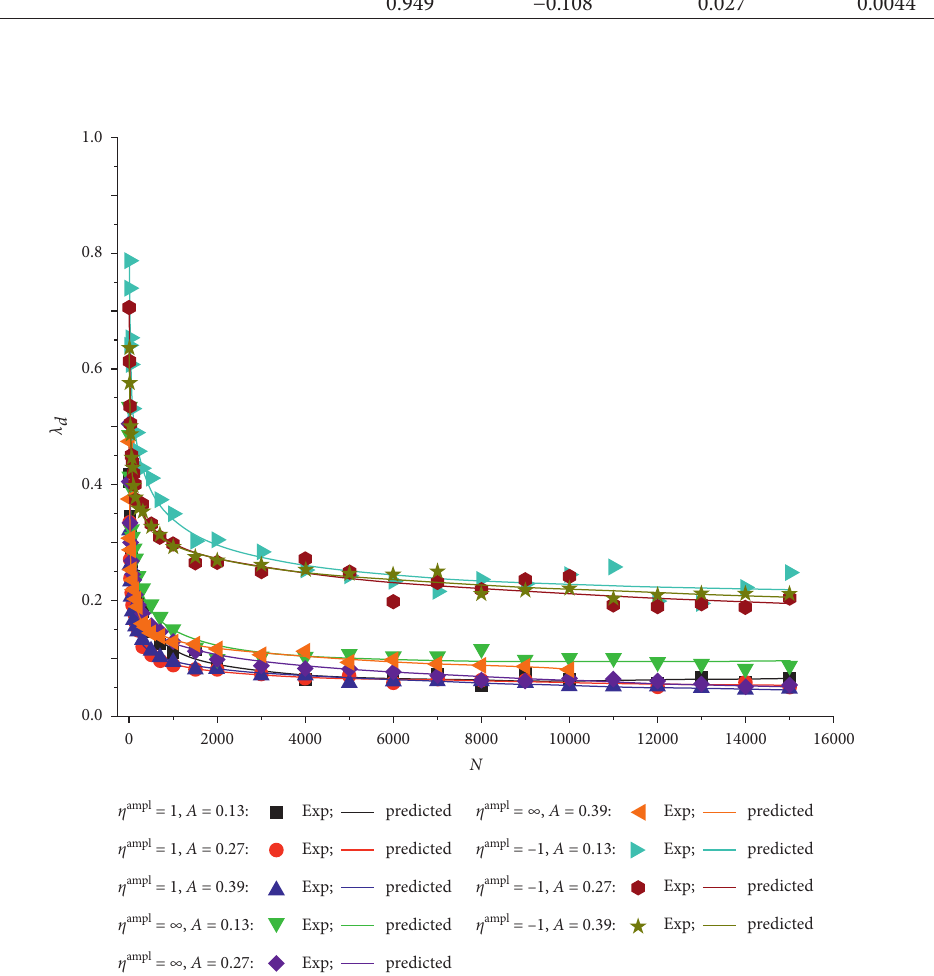
Figure 11: The damping ratios with an increase in the number of load cycles under different dynamic stress